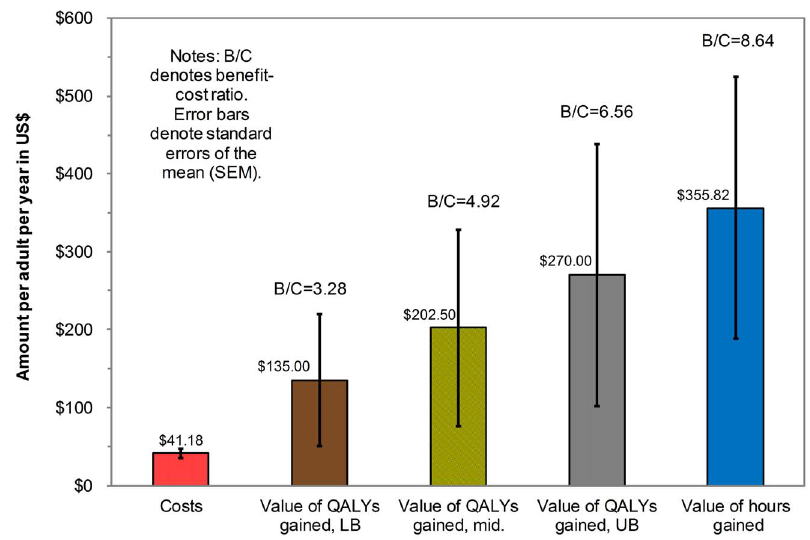
Figure 1. Costs and net benefits per adult resident of the AW-IPM project based on the value of the hours and QALYs gained. Note: LB denotes lower bound, mid. denotes midpoint; UB denotes upper bound.